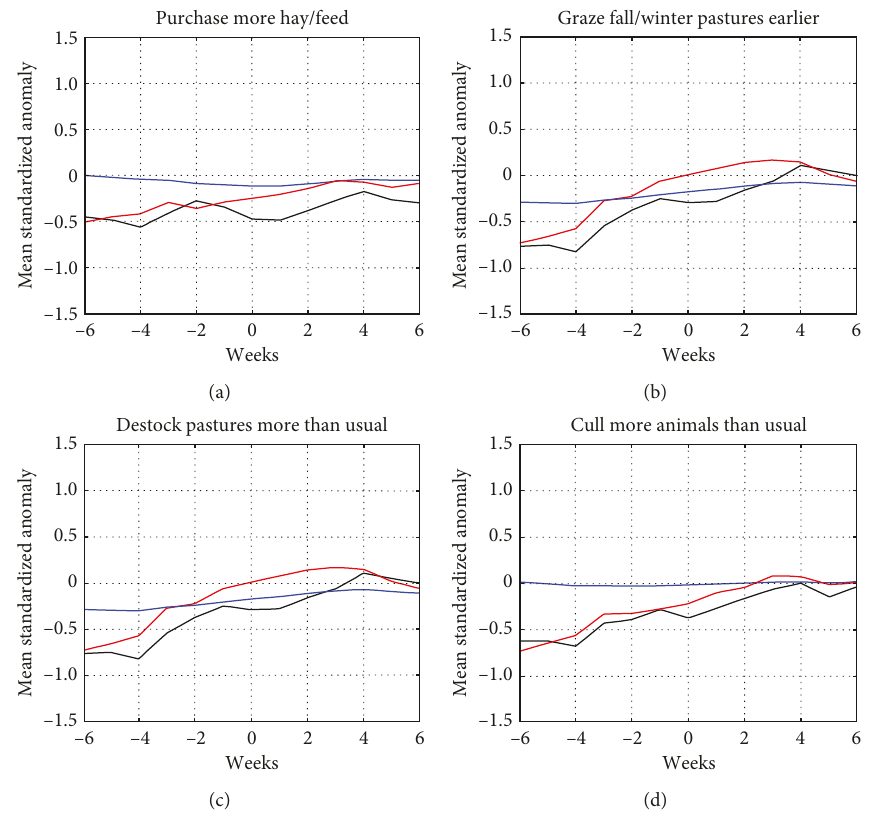
Figure 4: Time series showing the average condition depicted by anomalies in the ESI (black line) NLDAS TS (red line) and NLDAS TS (blue line) data sets at weekly intervals from six weeks prior to six weeks after the average beginning of drought response actions, including (a) purchasing more hay or feed than usual, (b) grazing fall/winter pastures earlier than usual, (c) destocking pastures more than usual, and (d) culling more breeding animals than